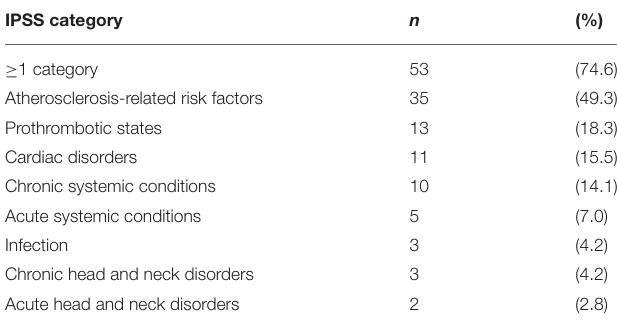
TABLE 3 | The IPSS category in stroke of undetermined